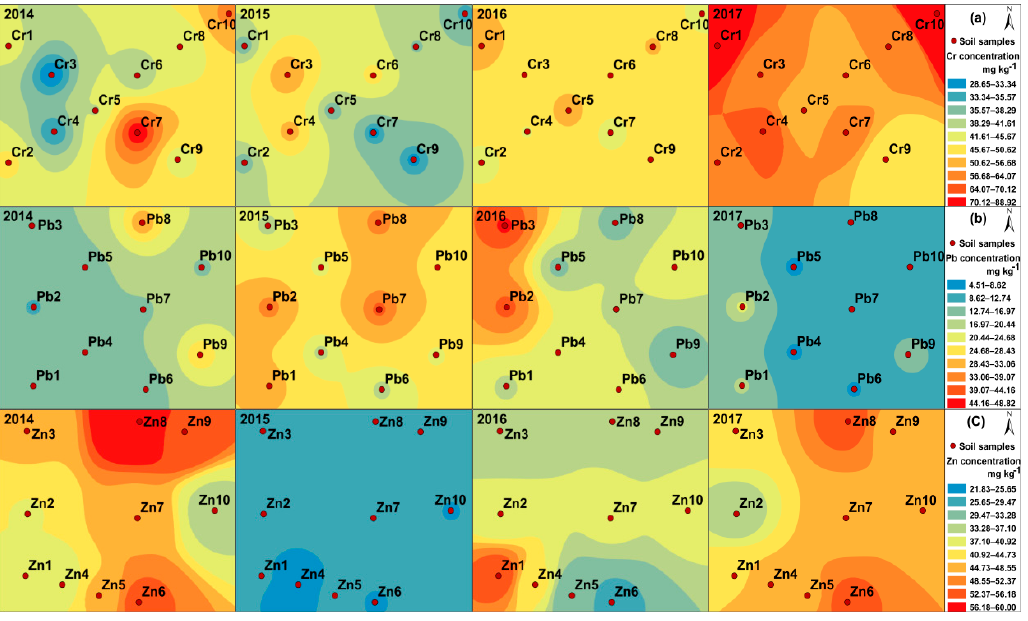
Figure 2. Spatial distributions of heavy metal concentrations in soil from 2014 to 2017: ( a ) Cr addition site; ( b ) Pb addition site; and ( c ) Zn addition site.